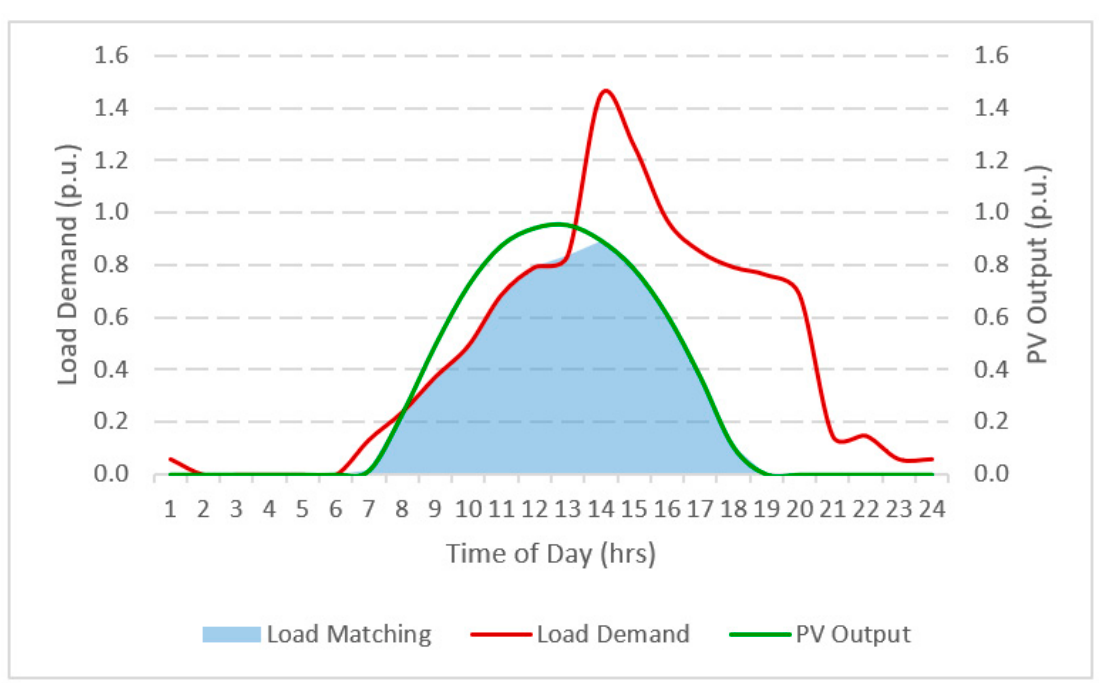
Figure 14. Load matching in 2030.